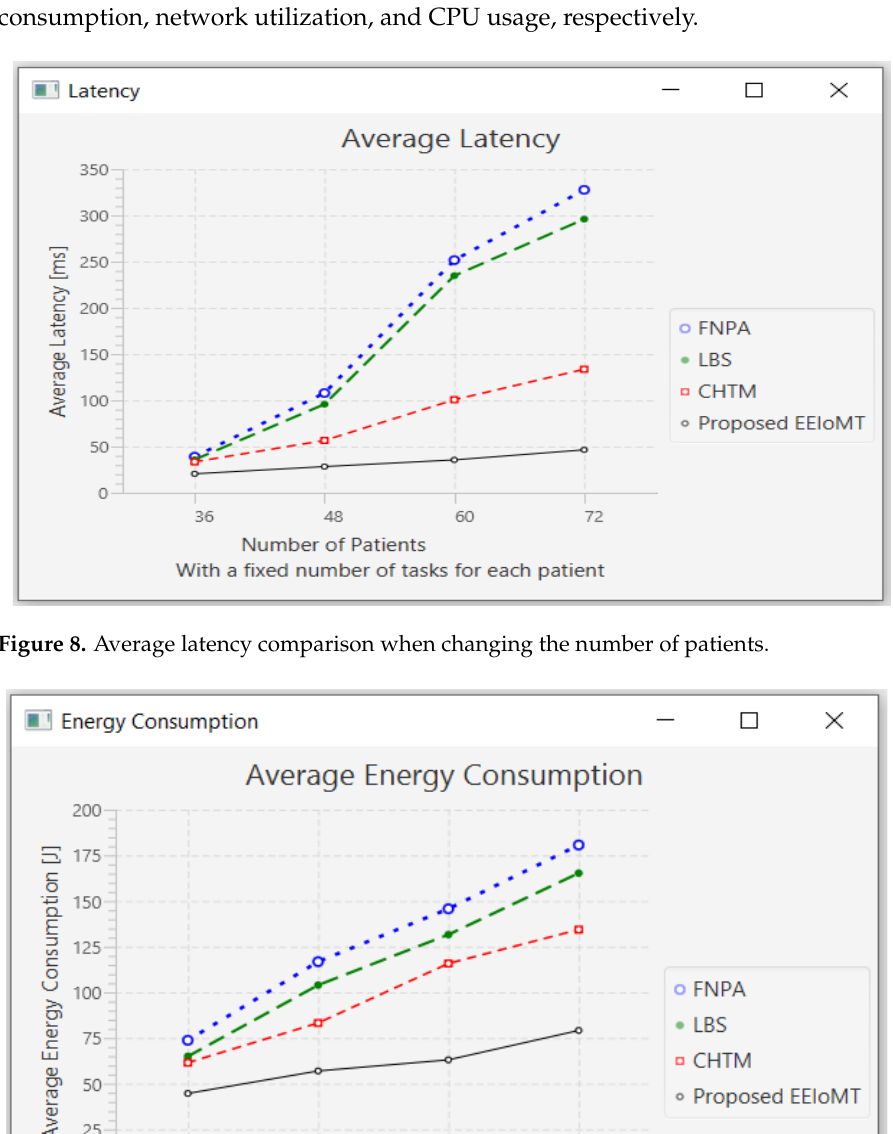
Figure 10. Network usage comparison when changing the number of patients. Figure 11. CPU usage comparison when changing the number of patients. To allocate workload, FNPA chooses the fog node with the shortest distance and most resources (bandwidth, RAM, and CPU). When the number of users grows to the